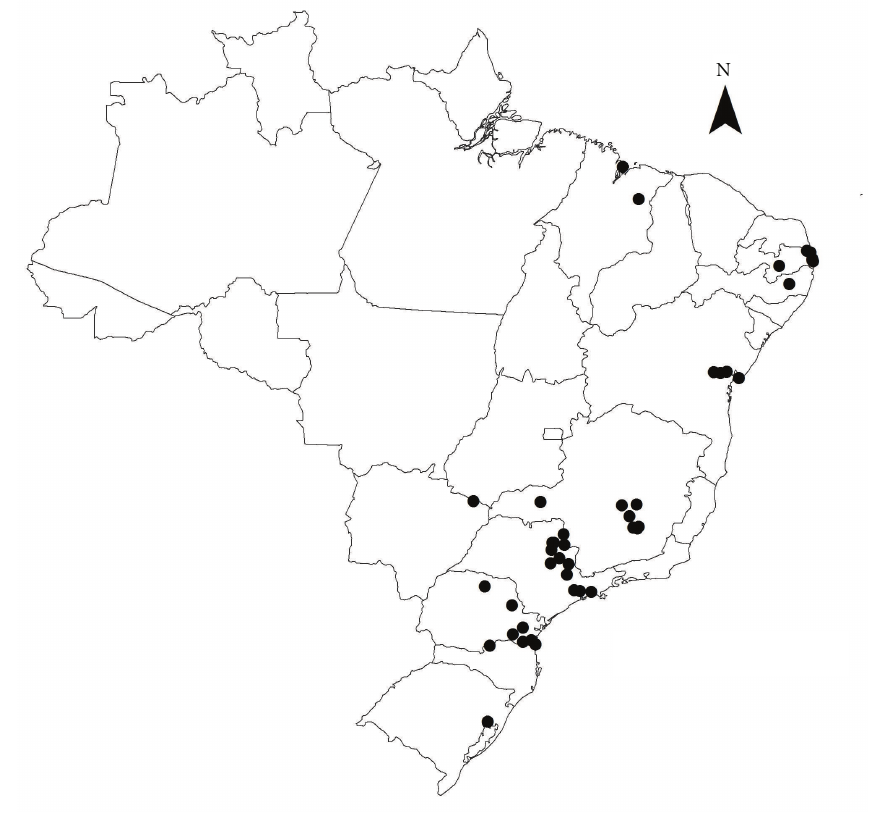
Figure 1: Brazilian localities where the bee surveys were